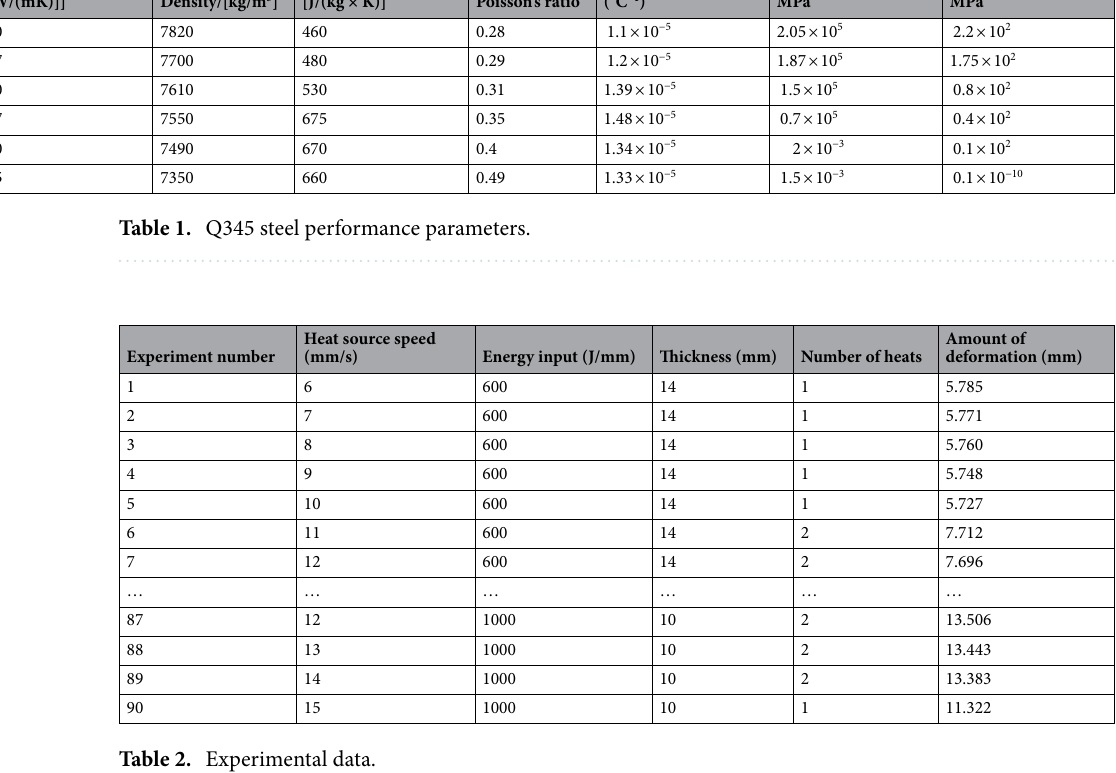
Table 2. Experimental